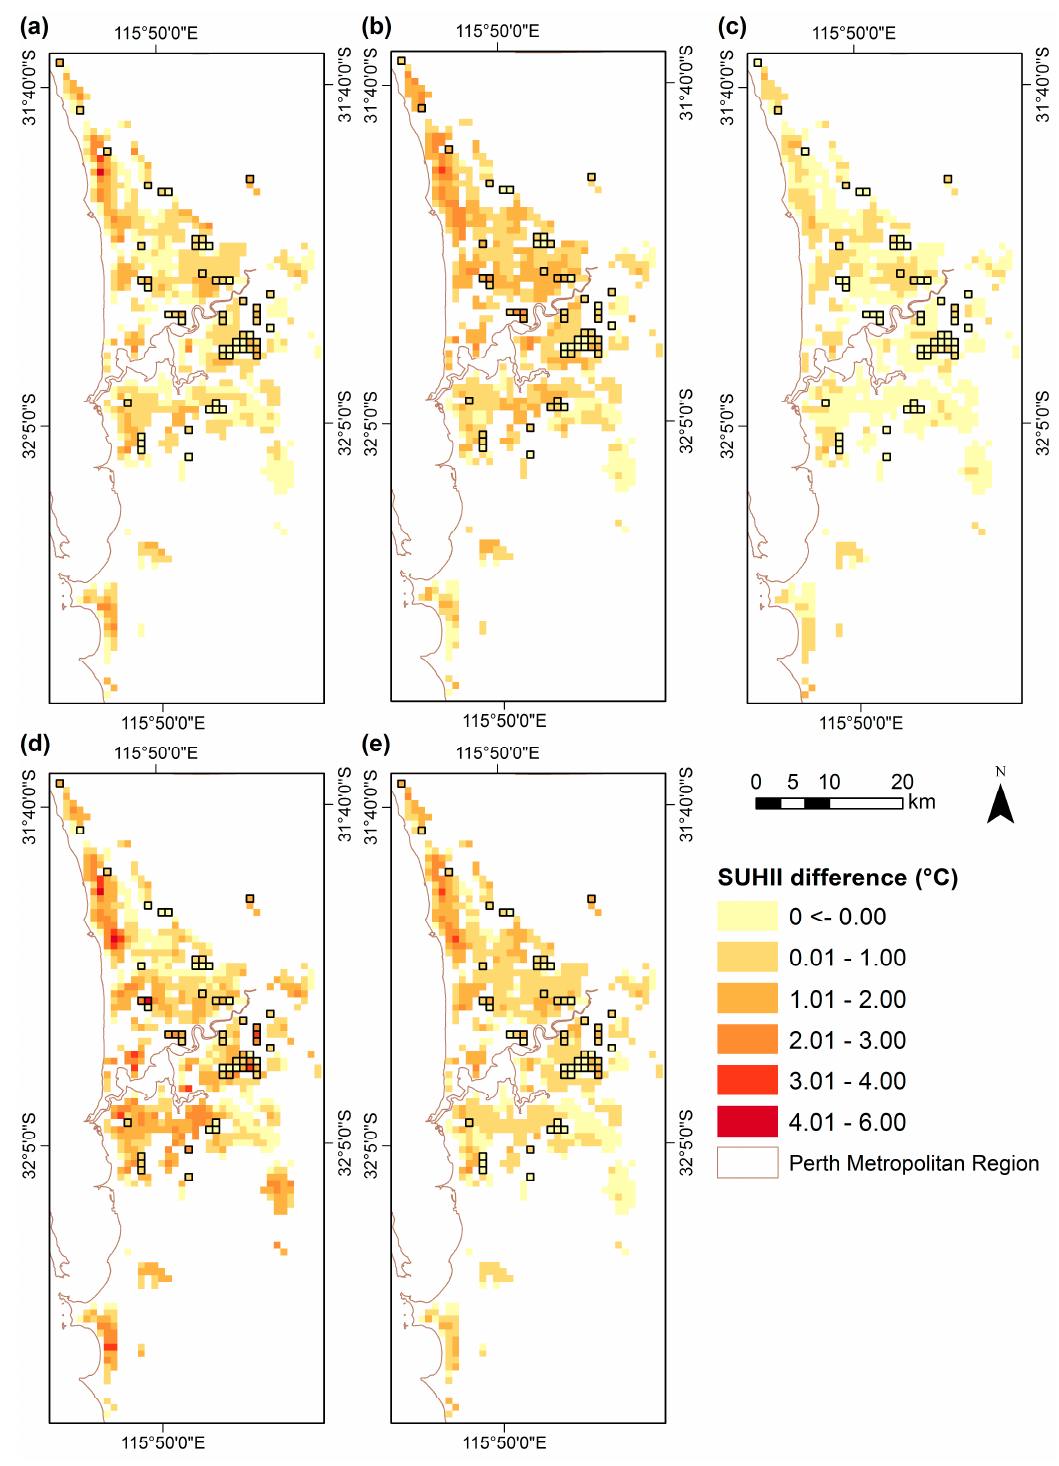
Figure 6. The spatial distribution of the difference in daytime SUHII for pixels that remained urban between 2013 and 2003 for: ( a ) summer ( b ) autumn ( c ) winter ( d ) spring and ( e ) annual. Urban (low and high albedo) and forest MODIS pixels are identified where a single Landsat land cover class composes >50% of a MODIS pixel. Black outlined MODIS pixels represent high urban albedo.